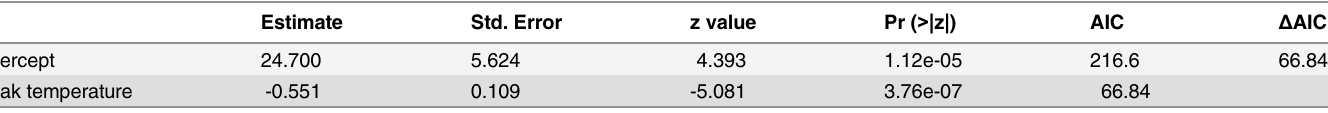
Table 8. Output summary of the logistic regression model of survival of E . atala pupae as a function of peak temperature following laboratory water bath experiment, February, 2012.